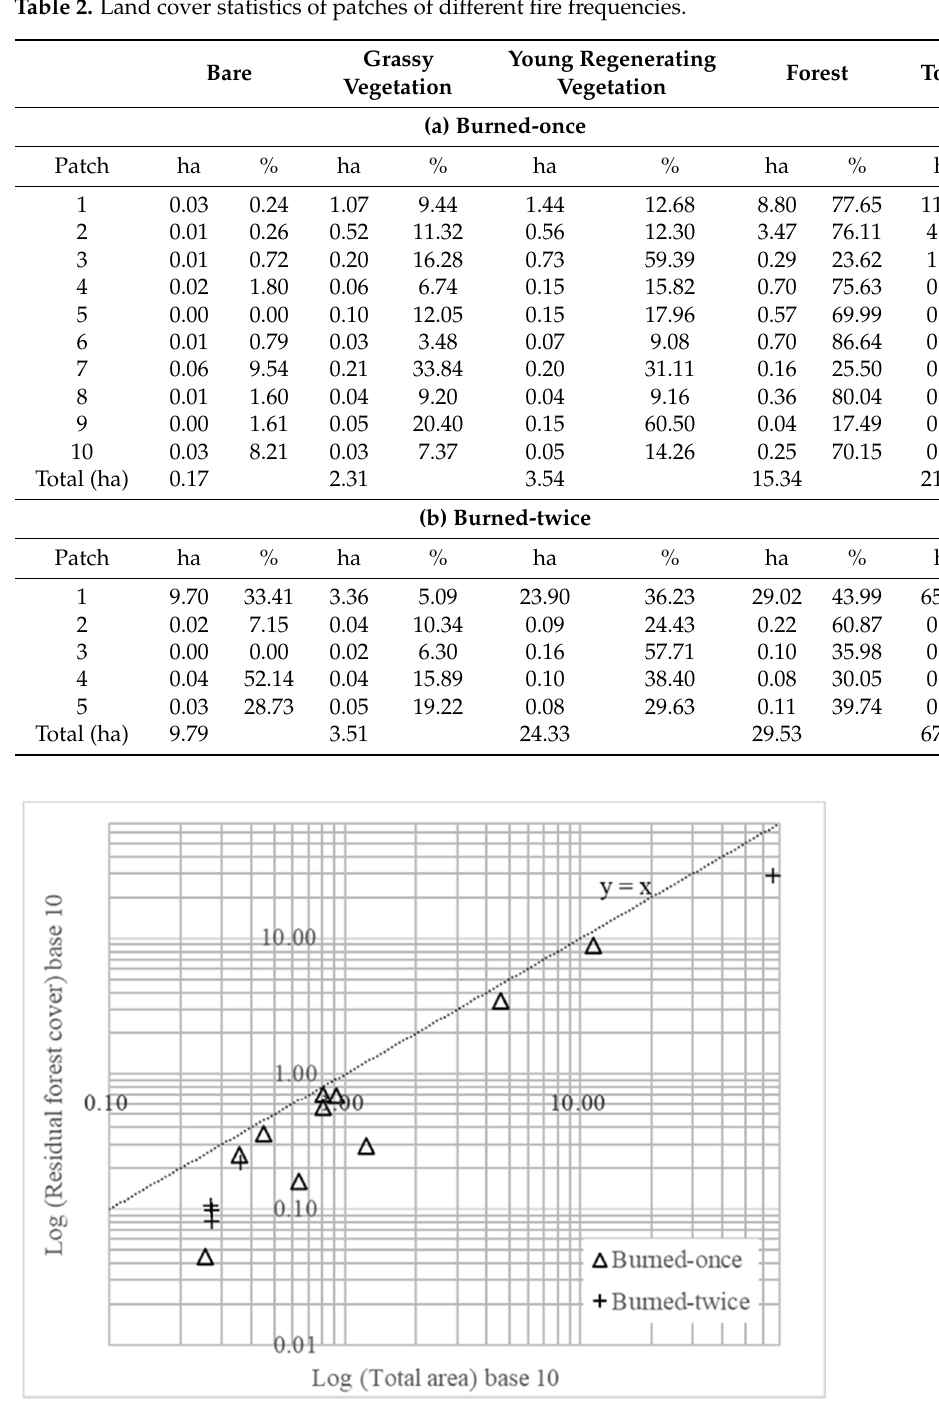
Figure 4. Relationship between total area and residual forest cover of the burned patches by fire frequency.